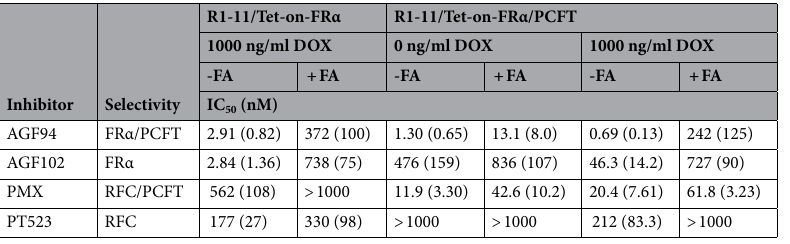
Table 1. Drug sensitivities (IC 50 values) of R1-11/Tet-on-FRα and R1-11/Tet-on-FRα/PCFT (“double”) HeLa cells . The cells were plated in 96-well culture plates (4,000 cells/well; 200 μl/well) with complete FF RPMI 1640 including 10% dialyzed FBS, 2 mM l-glutamine, and antibiotics, supplemented with 25 nM LCV. Drugs were added, with concentrations from 1 to 1000 nM for AGF102, AGF94, PMX, and PT523, in the presence of DOX (1000 ng/ml). Cells were incubated from 96 to120 hours (depending on the growth of the cell models) at 37 °C in a CO 2 incubator. Cell viabilities were measured with a fluorescence-based viability assay (CellTiter-Blue; Promega) and a fluorescence plate reader (emission at 590 nm, excitation at 560 nm) for calculating the drug concentrations that inhibit growth by 50% (IC 50 ). To demonstrate FRα-mediated drug uptake, excess (200 nM) FA was added to parallel cultures. Results are shown as mean IC 50 values +/− standard errors (in parentheses) from 3 to 9 separate